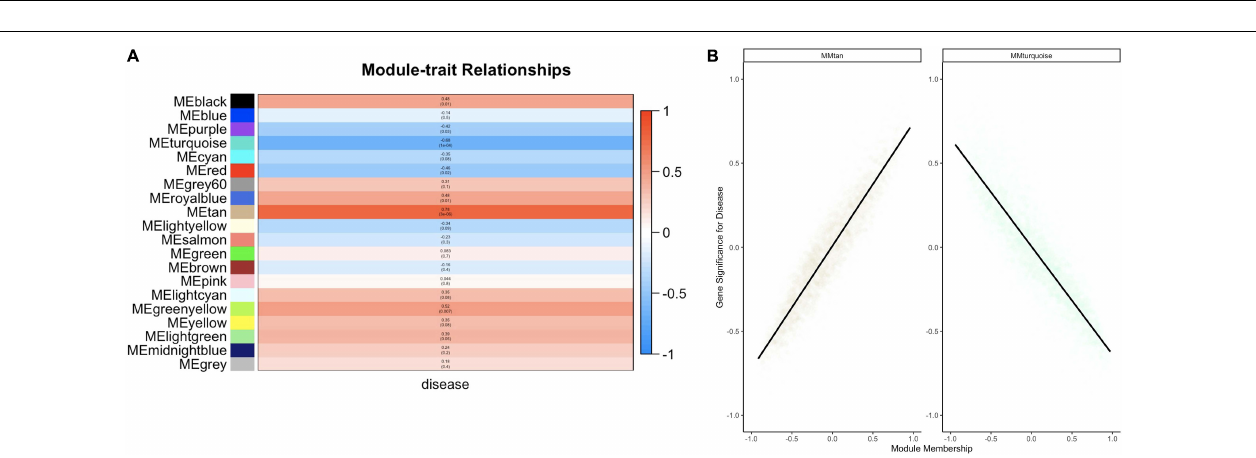
FIGURE 7 | WGCNA analysis within O. faveolata reveals modules significantly correlated to disease that is enriched for apoptosis and immune genes. (A) Modules with > 85% similar module eigengene expression were grouped together prior to module-trait relationship heatmap construction. Blue = negative correlation with disease, Red = positive correlation with disease based on Z-score. Within each bar, the top number indicates correlation strength and bottom number represents significance for each module. (B) Two modules were further investigated due to significant correlations for module membership and gene significance: the METan module and the METurquoise module. Smoothing of conditional means method linear model, with 95% confidence interval displayed around black